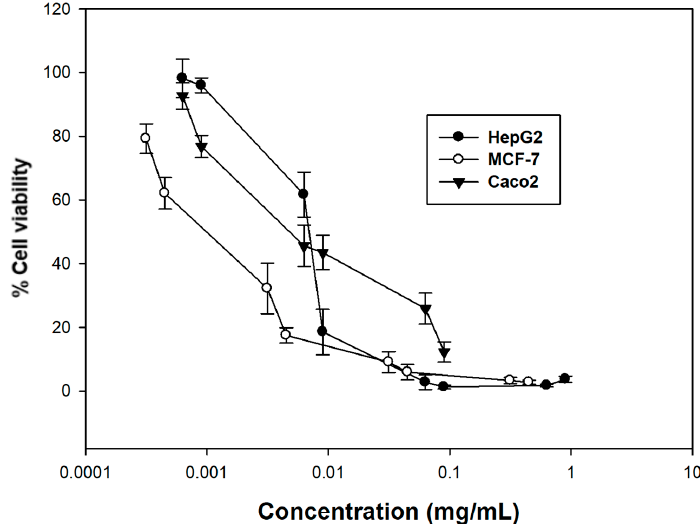
Figure 4. Antiproliferative activity of citral against a panel of three human cancer cell lines. Cancer cells were incubated with increasing concentrations of citral for 72 h. Estimation of cell viability was determined by the SRB assay. Representative figures of at least three experiments. Table 5. EC 50 values of the essential oil of Lippia citriodora and its major component, citral, against different human cell lines. Etoposide was used as a positive control. EC 50 ( μ g/mL) HepG2 Caco2